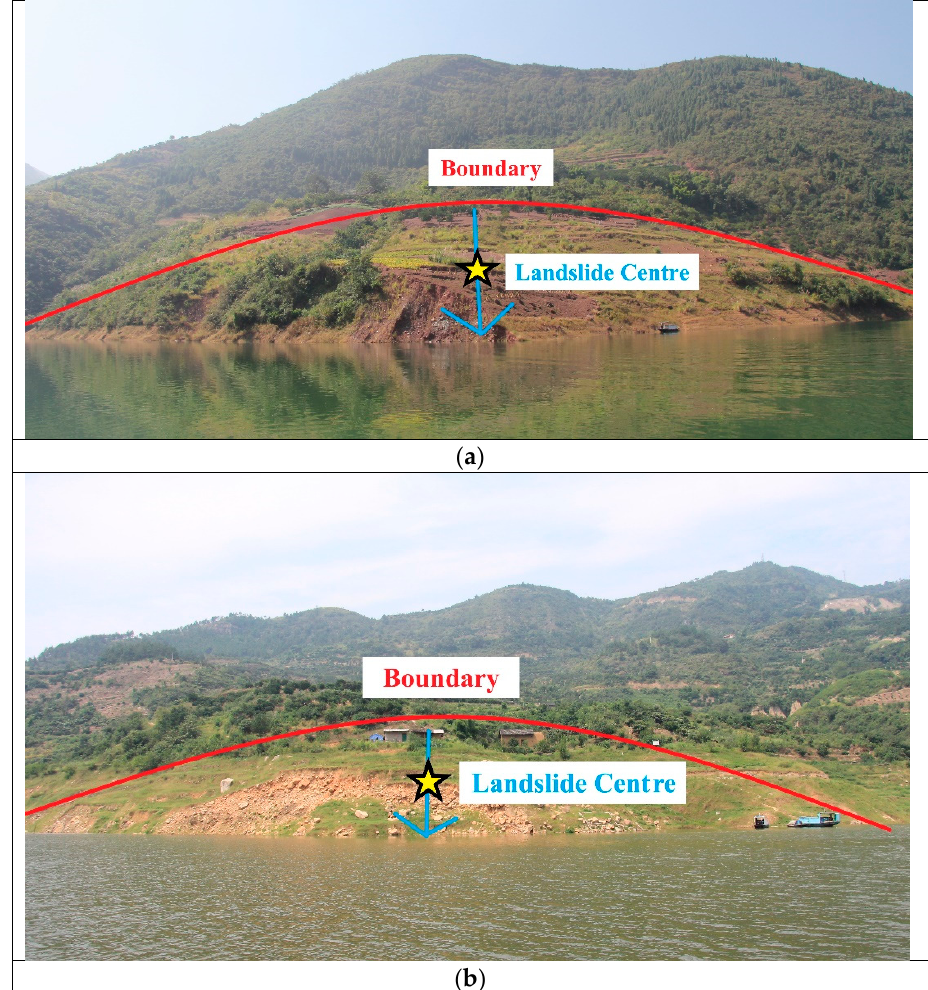
Figure 4. Field survey of landslides in Fengjie County: ( a ) the Xiawazhaping Landslide; ( b ) the Zhujiatian Landslide.